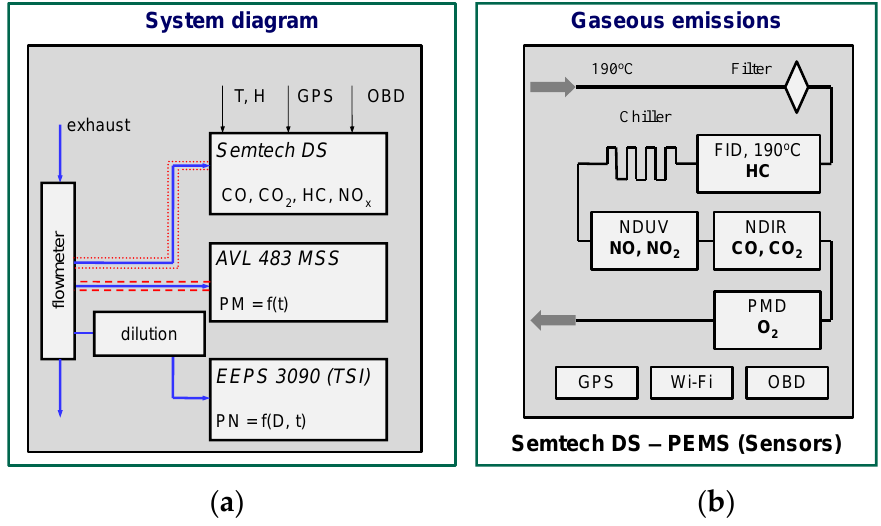
Figure 4. Measurement equipment for the RDE (Real Driving Emissions) tests ( a ) detailed diagram of the PEMS (Portable Emissions Measuring Systems) equipment ( b ).